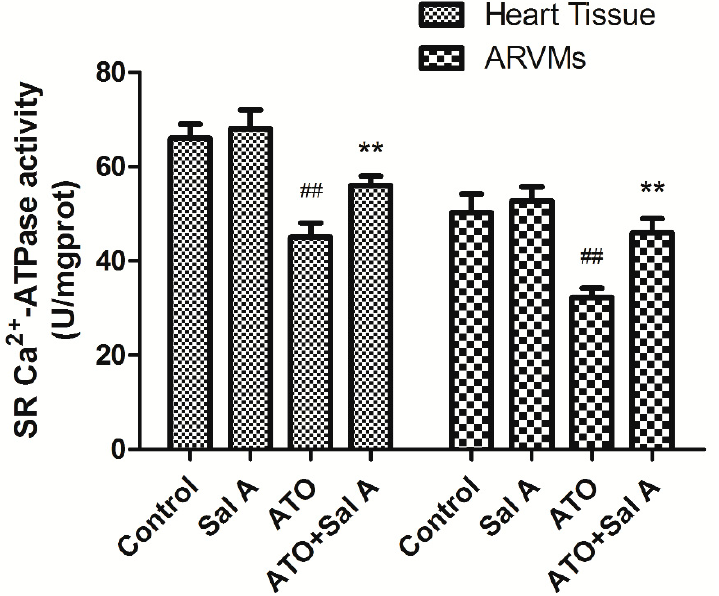
Figure 6. Sal A enhanced SERCA activity in ARVMs and mice heart tissue after ATO treatment. Data are expressed as the mean ± SD; ## p < 0.01 vs. control, ** p < 0.01 vs. ATO.